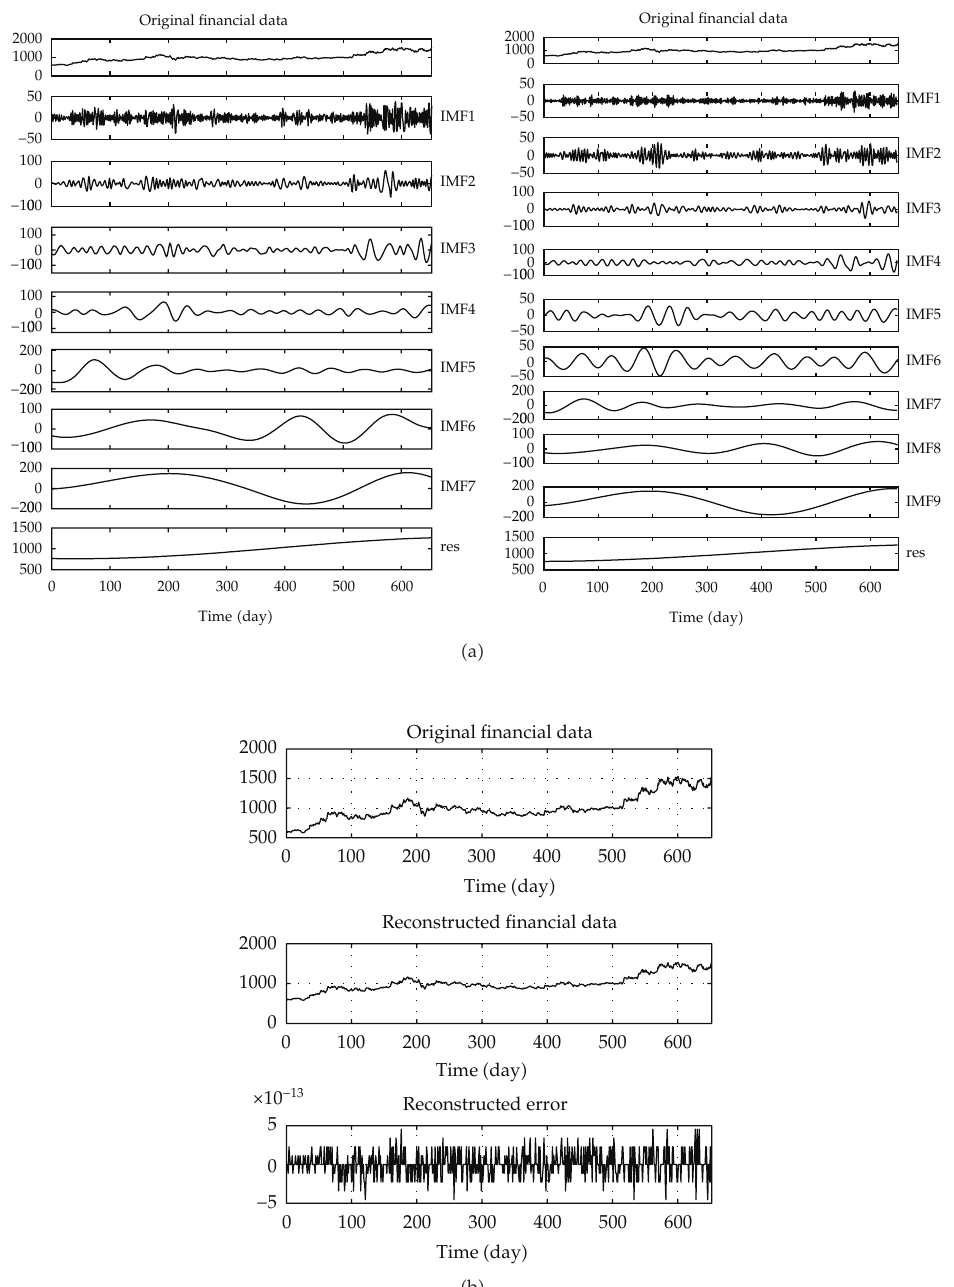
Figure 5: (cid:2) a (cid:3) The results of the EMD and N-A MEMD application for financial data on channel-1. The left and right column represents the IMFs of EMD and MEMD, respectively. (cid:2) b (cid:3) Original financial data for channel 1 (cid:2) top (cid:3) , reconstructed signal by simply adding the IMFs (cid:2) including the residue (cid:3) of MEMD (cid:2) middle (cid:3) and reconstructed error (cid:2) bottom (cid:3) . The SNR of the reconstructed signal is